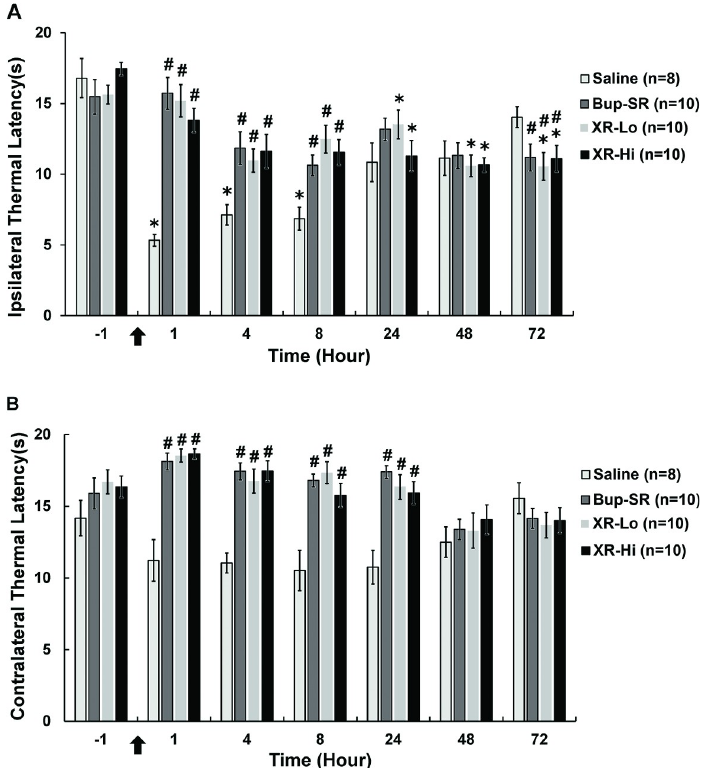
Fig 2. Thermal hypersensitivity results. Thermal hypersensitivity of the ( A ) ipsilateral thigh measured in sec; mean ± SEM; � = Values significantly (P < 0.05) different from that of -1 h (baseline) for the same treatment group. # = Values significantly (P < 0.05) different compared to the Saline group at the same time point. ( B ) Contralateral thigh measured in sec; mean ± SEM. � = Values significantly (P < 0.05) different from that of -1 h (baseline) for the same treatment group. # = Values significantly (P < 0.05) different compared to the Saline group at the same time point. Arrow indicates the time of surgery. (15.5 ± 1.2 sec, baseline) in the ipsilateral thigh. Compared to its baseline values at -1 h (15.6 ± 0.7 sec), XR-Lo’s thermal latency significantly decreased (more sensitive) at 48 (10.6 ± 0.8 sec), and 72 (10.6 ± 1.0 sec) h. Compared to its baseline values -1 h (17.4 ± 0.5 sec), XR-Hi’s thermal latency significantly decreased (more sensitive) at 8 (11.6 ± 0.9 sec), 24 (11.3 ± 1.1 sec), 48 (10.7 ± 0.5 sec), 72 (11.1 ± 0.9 sec) h. Contralateral thigh . No significant differences in thermal latency were observed between any group at any time points from their baseline measurements (Saline = 14.2 ± 1.2 sec; Bup- SR = 15.9 ± 1.1 sec; XR-Lo = 16.7 ± 0.8 sec; XR-Hi = 16.3 ± 0.8 sec). Comparison between drug groups at the same time point. Ipsilateral thigh . Compared to the Saline group, the thermal latency for the Bup-SR, XR-Lo and XR-Hi groups were signifi- cantly increased (less sensitive) at 1 (Saline = 5.3 ± 0.4 sec; Bup-SR = 15.7 ± 1.1 sec; XR-Lo = 15.2 ± 1.1 sec; XR-Hi = 13.8 ± 0.9 sec), 4 (Saline = 7.1 ± 0.7 sec; Bup-SR = 11.8 ± 1.2 sec; XR-Lo = 11.0 ± 0.8 sec; XR-Hi = 11.6 ± 1.2 sec), 8 (Saline = 6.9 ± 0.8 sec; Bup- SR = 10.6 ± 0.7 sec; XR-Lo = 12.5 ± 1.0 sec; XR-Hi = 11.6 ± 0.9 sec), and decreased (more sen- sitive) at 72 (Saline = 14.0 ± 0.7 sec; Bup-SR = 11.2 ± 1.0 sec; XR-Lo = 10.6 ± 1.0 sec; XR-Hi = 11.1 ± 1.0 sec) h. The thermal latency for the Bup-SR, XR-Lo and XR-Hi groups was not significantly different between groups at any time point throughout the study.